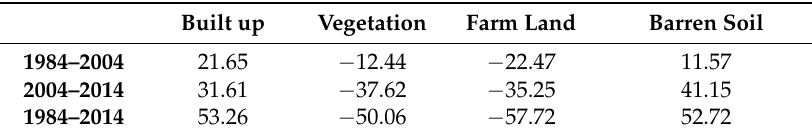
Figure 7. Land use change from 1984 to 2014. Table 2. Changes in urban land use area in the Erbil basin from 1984 to 2014.